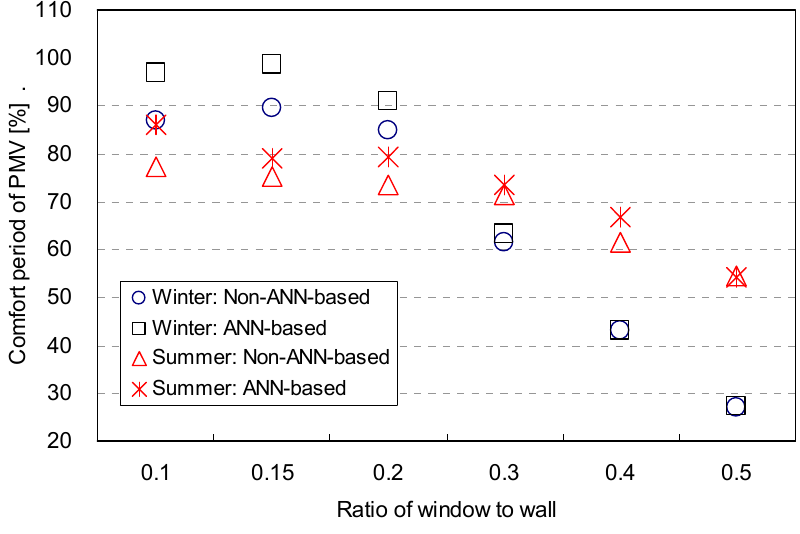
Figure 12. PMV comfort periods based on ratio of window to